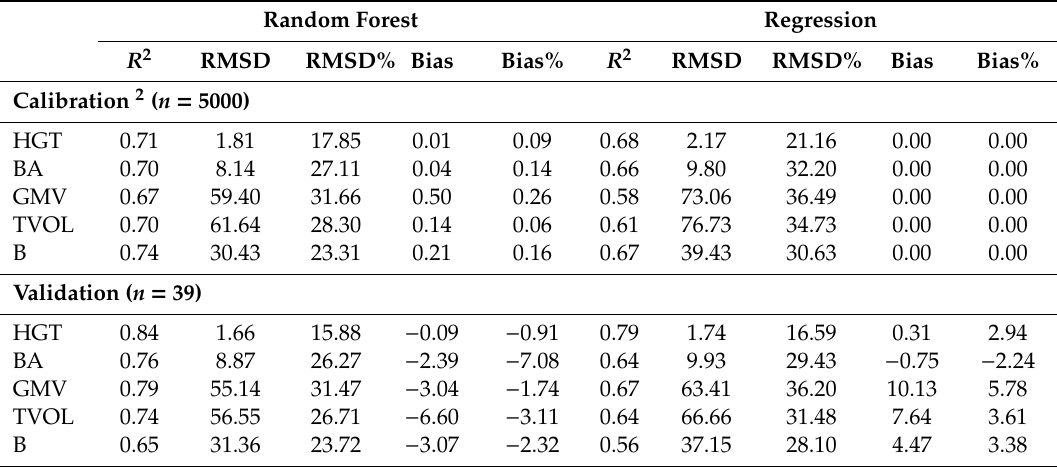
Table 4. Evaluation statistics for prediction of forest attributes with satellite and environmental variables 1